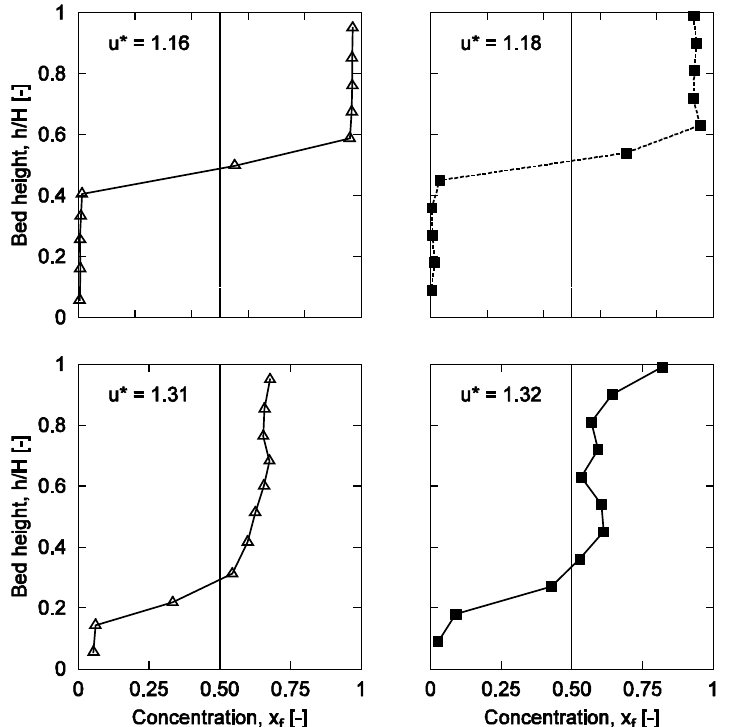
Fig. 1 Experimental (left) and simulated (right) flotsam volumetric concentration along the dimension- less bed height. The top row corresponds to low velocity and the bottom row to high velocity, as indicated. Simulation conditions are reported in Table 2